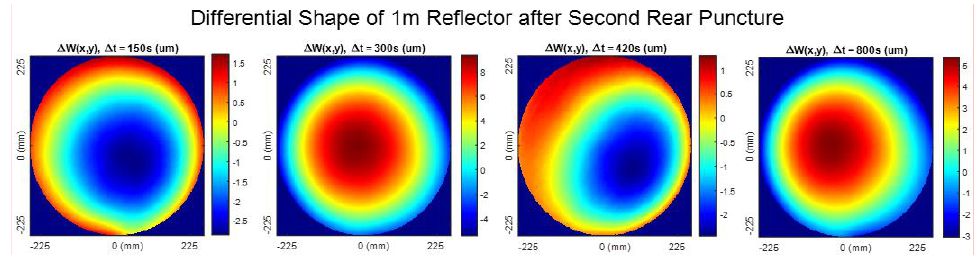
Figure 11. The second puncture showed recovery without substantial dynamic change over tens of minutes. Chamber pressure increased from 7.07 Pa to 10.66 Pa after the second puncture. A third puncture brought the chamber pressure to 13.33 Pa.